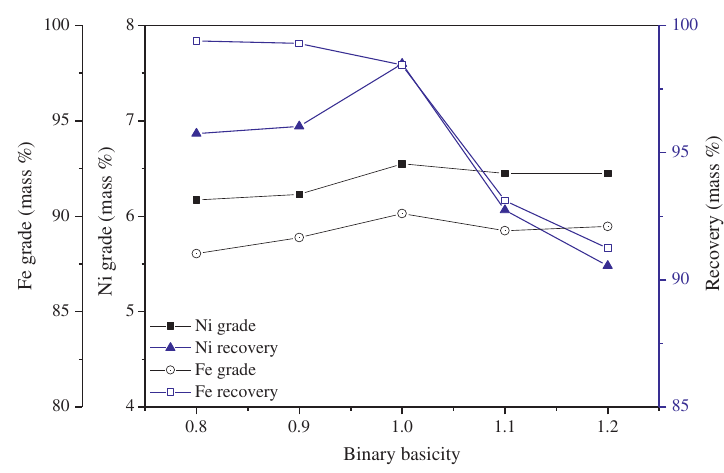
Figure 5: Effects of binary basicity on Fe and Ni grade and recovery of ferronickel (Smelting at 1,550°C for 10 min, with coke ratio of 10%, 18% of MgO and 3% of Al 2 O 3 in